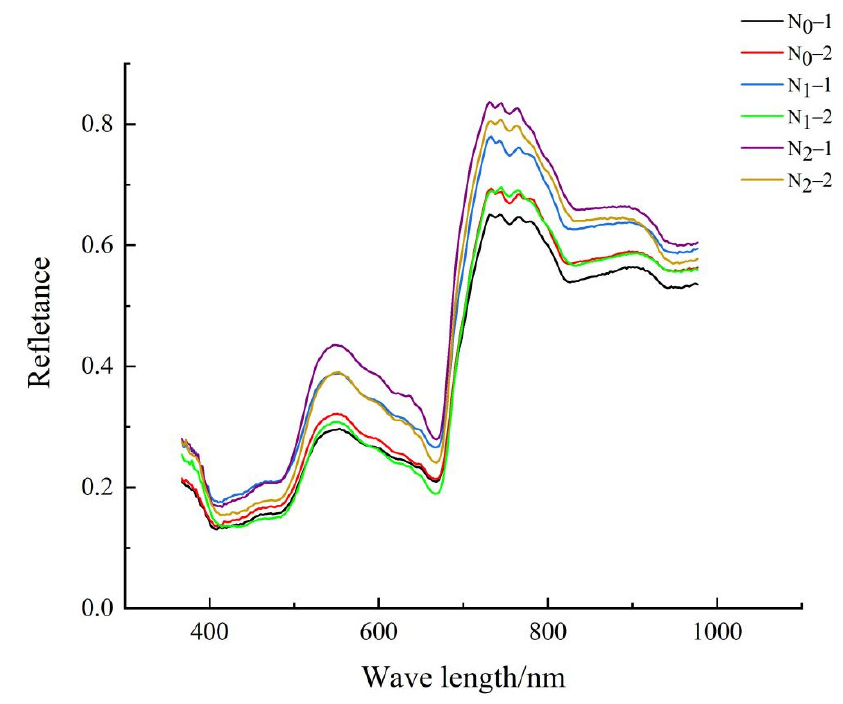
Figure 2. Spectral graphs of 6 samples.